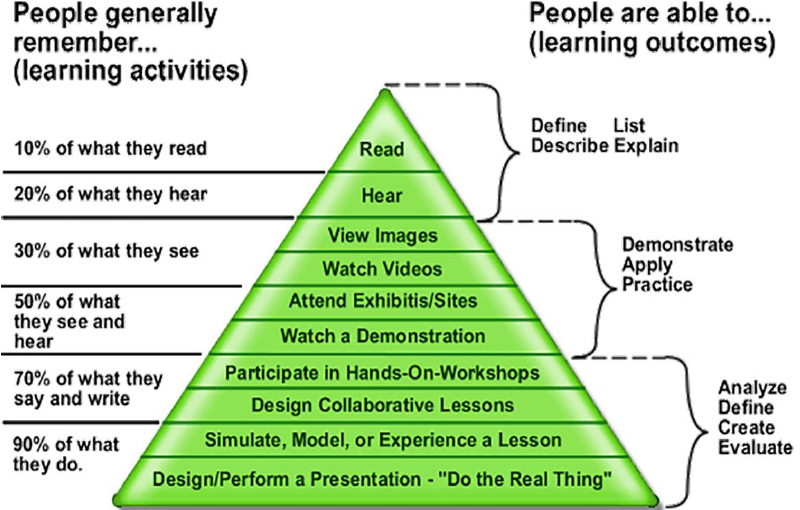
Figure 1. Edgar Dale’s Cone of Experience shows that after two weeks we mainly remember information coming from what we have told or done (active participation), rather than those ones coming from what we have read, listened to or looked at. Audio-visual stimuli together, but with passive engagement, are in the middle of the cone. Image source: http://www.edutechie.ws/2007/10/09/cone-of-experience-media/, Author Jeffrey Anderson.